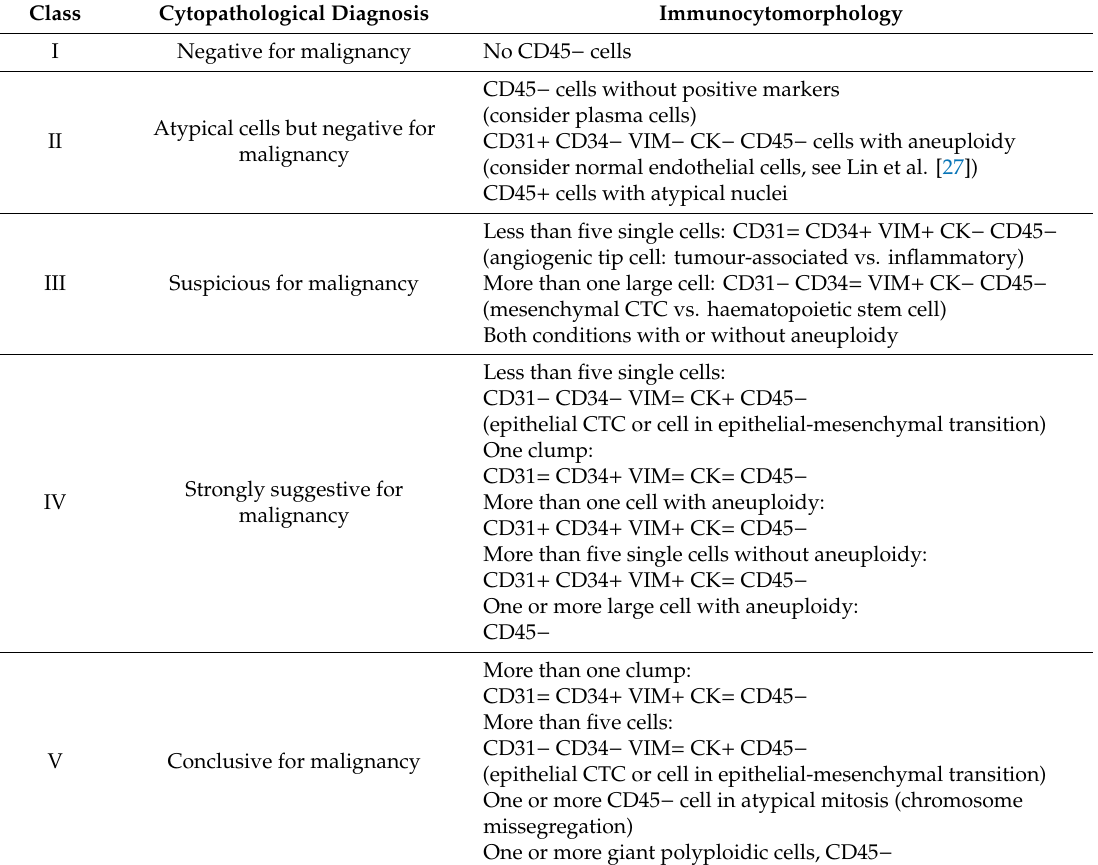
Table 4. Circulating endothelial cell (CEC) / circulating tumour cell (CTC) cytopathological criteria. + positive; − negative; = positive or